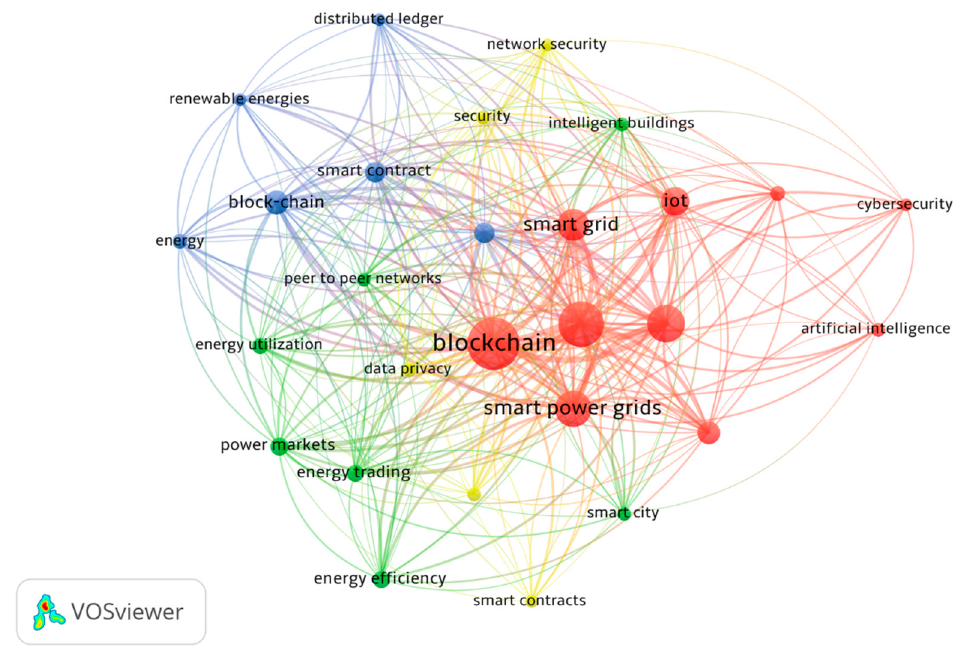
Figure 3. Map of co-occurrence matrix.